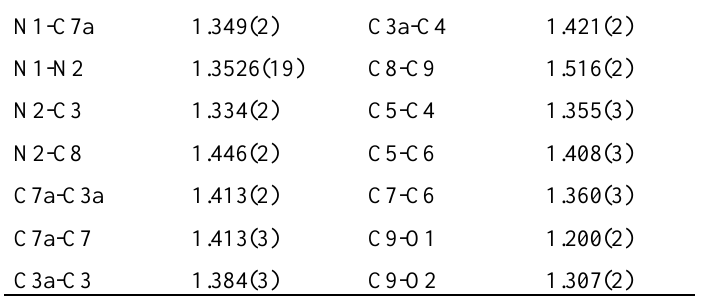
Table 6. Bond lengths [Å], angles [º] and other structural parameters for compound